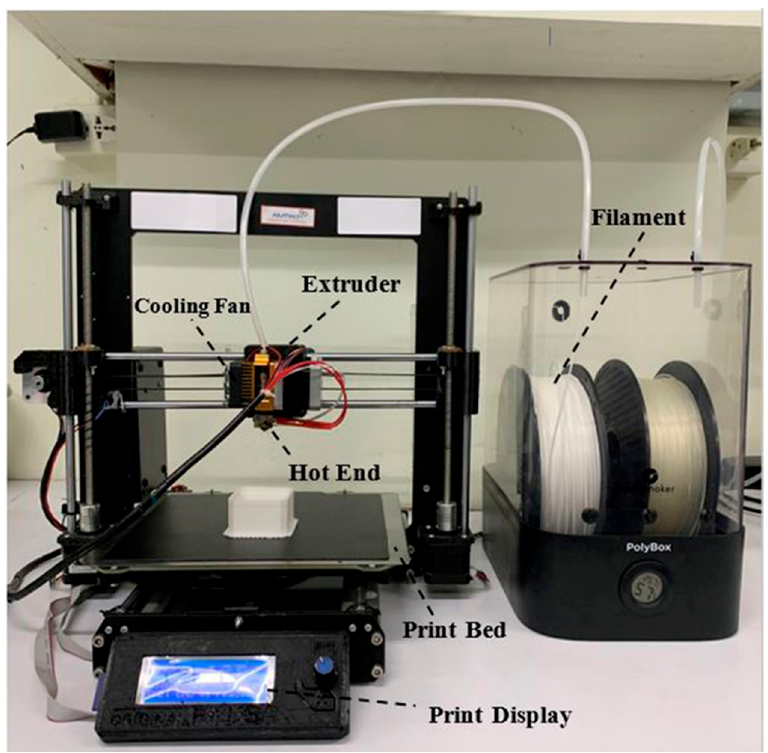
Figure 2. Homemade fused filament fabrication (FFF) 3D printer.